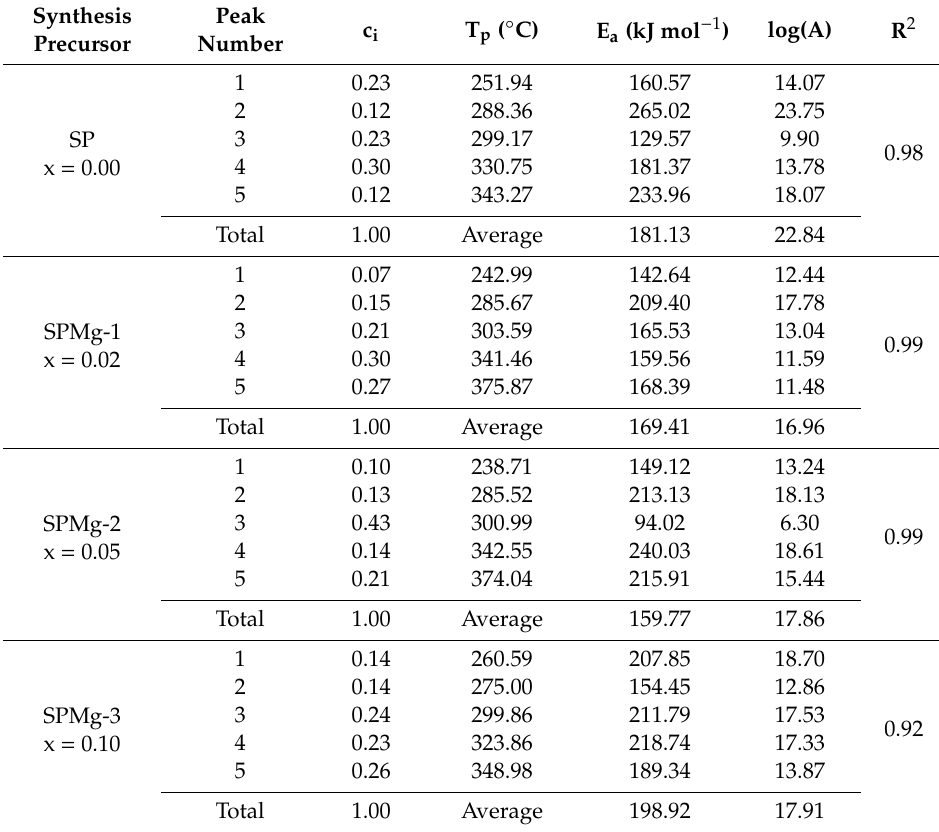
Table 3. Kinetic parameters, contribution factors, peak temperatures, and correlation coe ffi cients from fit of experimental conversion rates of polymeric matrix thermal decomposition with a scheme of five successive